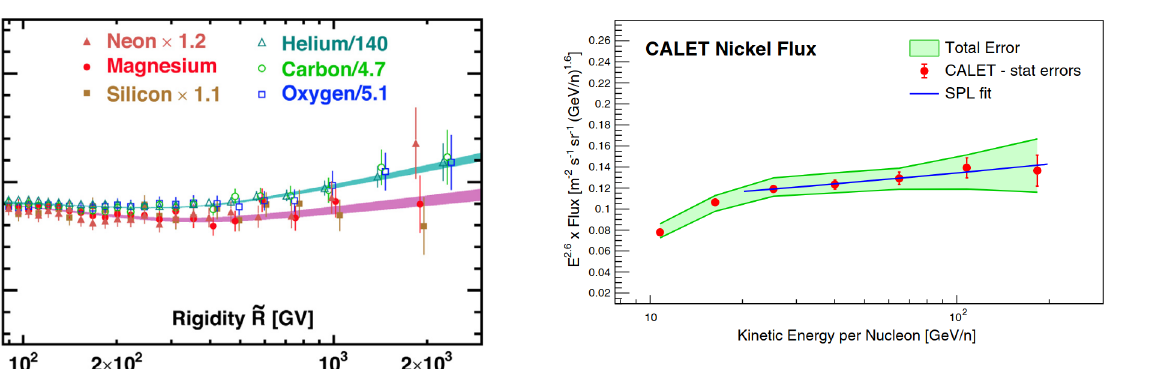
Figure 7. Neon, Magnesium and Silicon spectra compared with Carbon, Oxygen and Helium spectra measured by AMS-02 [6].